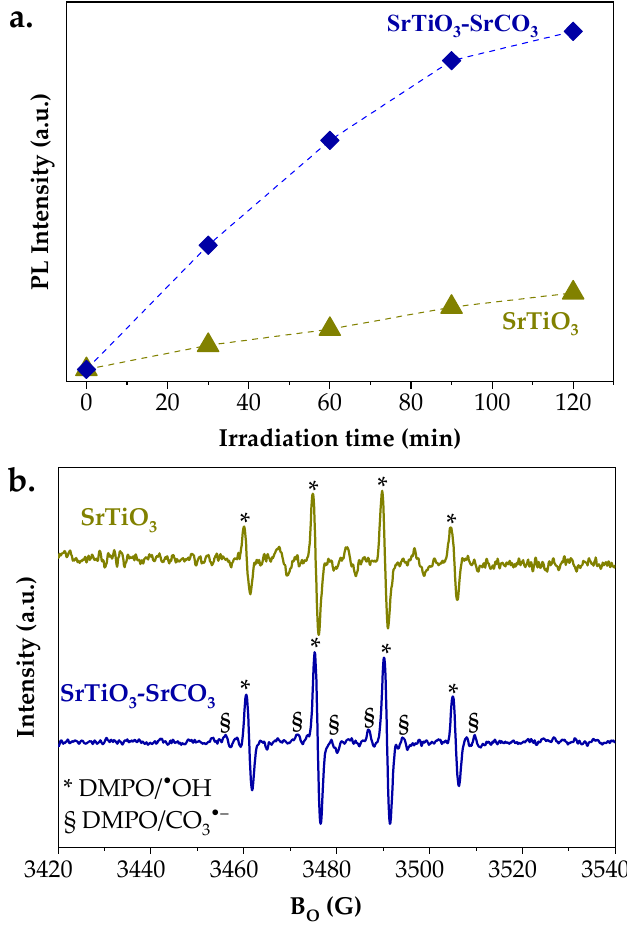
Figure 7. ( a ). Time-dependent terephthalic acid hydroxylation in the cases of cSTO and STO_15_SCO. ( b ). In-situ EPR spectra of the reaction mixture after the addition of DMPO in the presence of cSTO and STO_15_SCO.